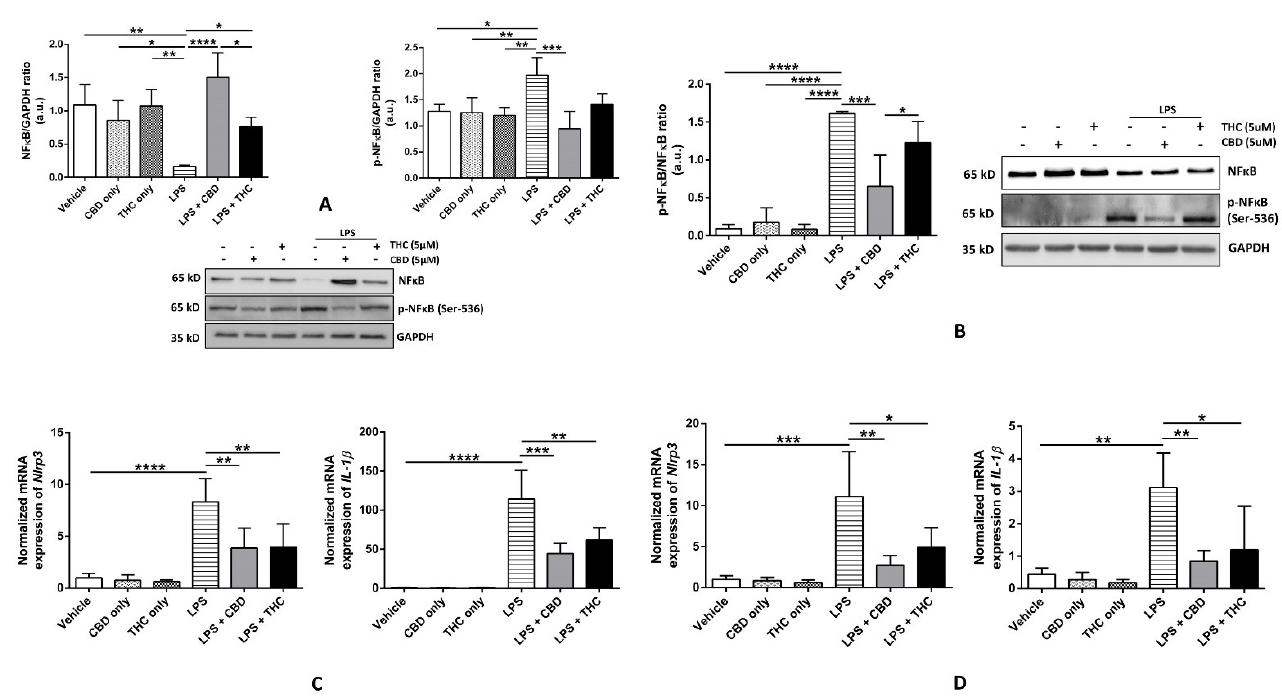
Figure 3. Effect of cannabinoids on the NF κ B-mediated gene expression in THP-1 macrophages and primary human bronchial epithelial cells. ( A ): CBD, not THC, decreased the expression of phospho-NF κ B p65 (Ser-536) after LPS stimulation in THP-1 macrophages: Representative Western blots of NF κ B, p-NF κ B, and GAPDH bands and the quantification of the same using one-way ANOVA with Tukey’s multiple-comparison test. Four independent experiments ( n = 4) of THP-1 cell lysates obtained after pre-treatment with CBD or THC for 30 min and LPS stimulation for 3 h were analyzed, and data are expressed as means ± SD; * p < 0.05, ** p < 0.01, *** p < 0.001, **** p < 0.0001. ( B ): CBD, not THC, decreased the ratio of the expressions of phospho-NF κ B p65 (Ser-536)/NF κ B after LPS stimulation in primary HBECs: Representative Western blots of NF κ B, p -NF κ B, and GAPDH bands and the quantification of the same using one-way ANOVA with Tukey’s multiple-comparison test. Four independent experiments ( n = 4) of primary human bronchial epithelial cell lysates obtained after pre-treatment with CBD or THC for 30 min and LPS stimulation for 8 h were analyzed, and data are expressed as means ± SD; * p < 0.05, *** p < 0.001, **** p < 0.0001. (Abbreviation: HBECs: Human bronchial epithelial cells). ( C ): CBD and THC decreased the gene expression of Nlrp3 and Il-1 β after LPS stimulation in THP-1 macrophages: The mRNA expression of Nlrp3 and Il-1 β relative to GAPDH normalized to vehicle quantified using one-way ANOVA with Tukey’s multiple-comparison test. Four independent experiments ( n = 4) using total RNA isolated from THP-1 cells obtained after pre-treatment with CBD or THC for 30 min and LPS stimulation for 3 h were analyzed, and data are expressed as means ± SD; ** p < 0.01, *** p < 0.001, **** p < 0.0001. Each independent experiment was run in duplicates. ( D ): CBD and THC decreased the gene expression of Nlrp3 and Il-1 β after LPS stimulation in primary HBECs: The mRNA expression of Nlrp3 and Il-1 β relative to GAPDH